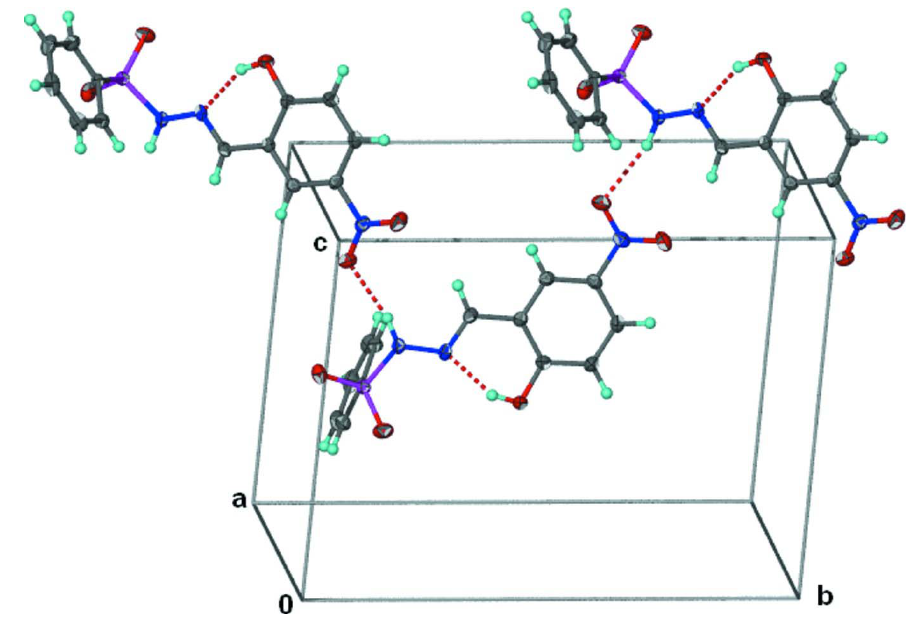
Figure 2 Hydrogen-bonded chain structure. Hydrogen bonds are denoted by dashed